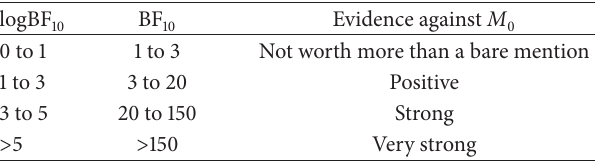
Table 1: The evidence about Bayes factor against 𝑀 0 [18]. logBF